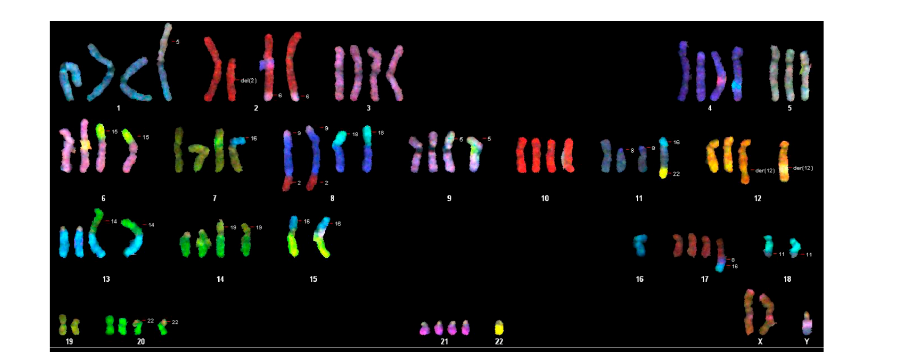
Figure 2. Illustration of detected chromosomes in WG-59 immortalized cultured cells in display colors, showing a pseudotriploid cell line with several aberrations.